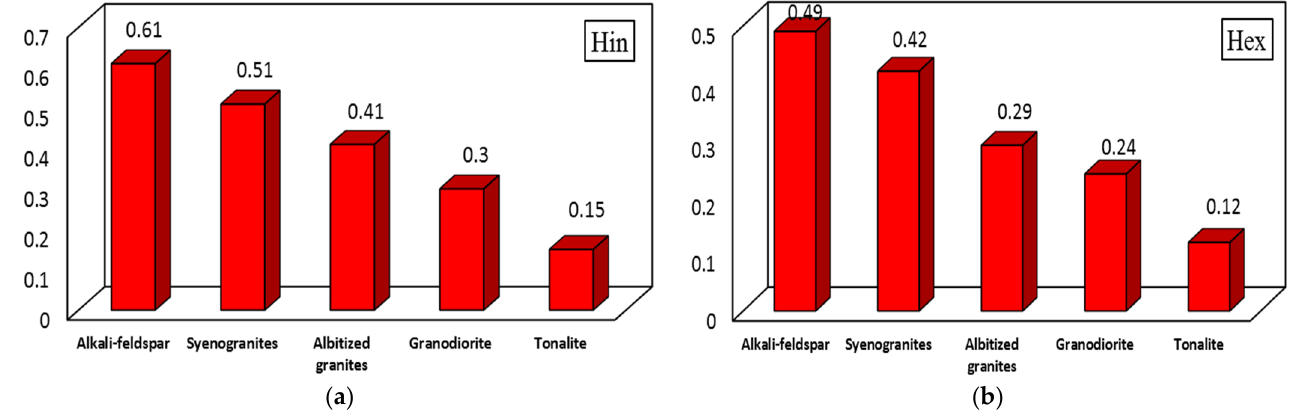
Figure 5. Hazard indices values. ( a ) Internal hazard index value (H in ) and ( b ) external hazard index value (H ex ).